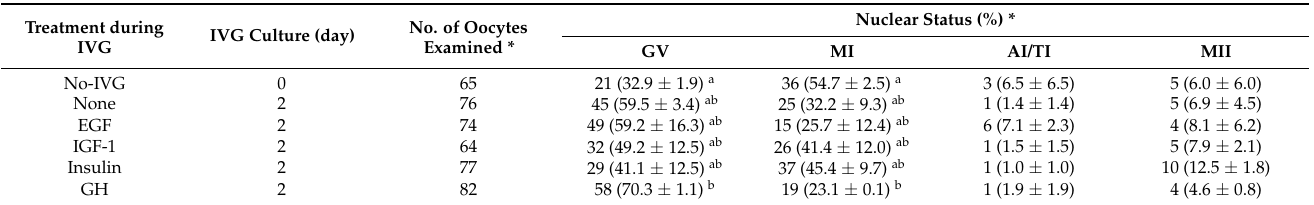
Table 5. Nuclear stage at 22 h of in vitro maturation of small antral follicle derived pig oocytes cultured in in vitro growth medium containing various growth factors or